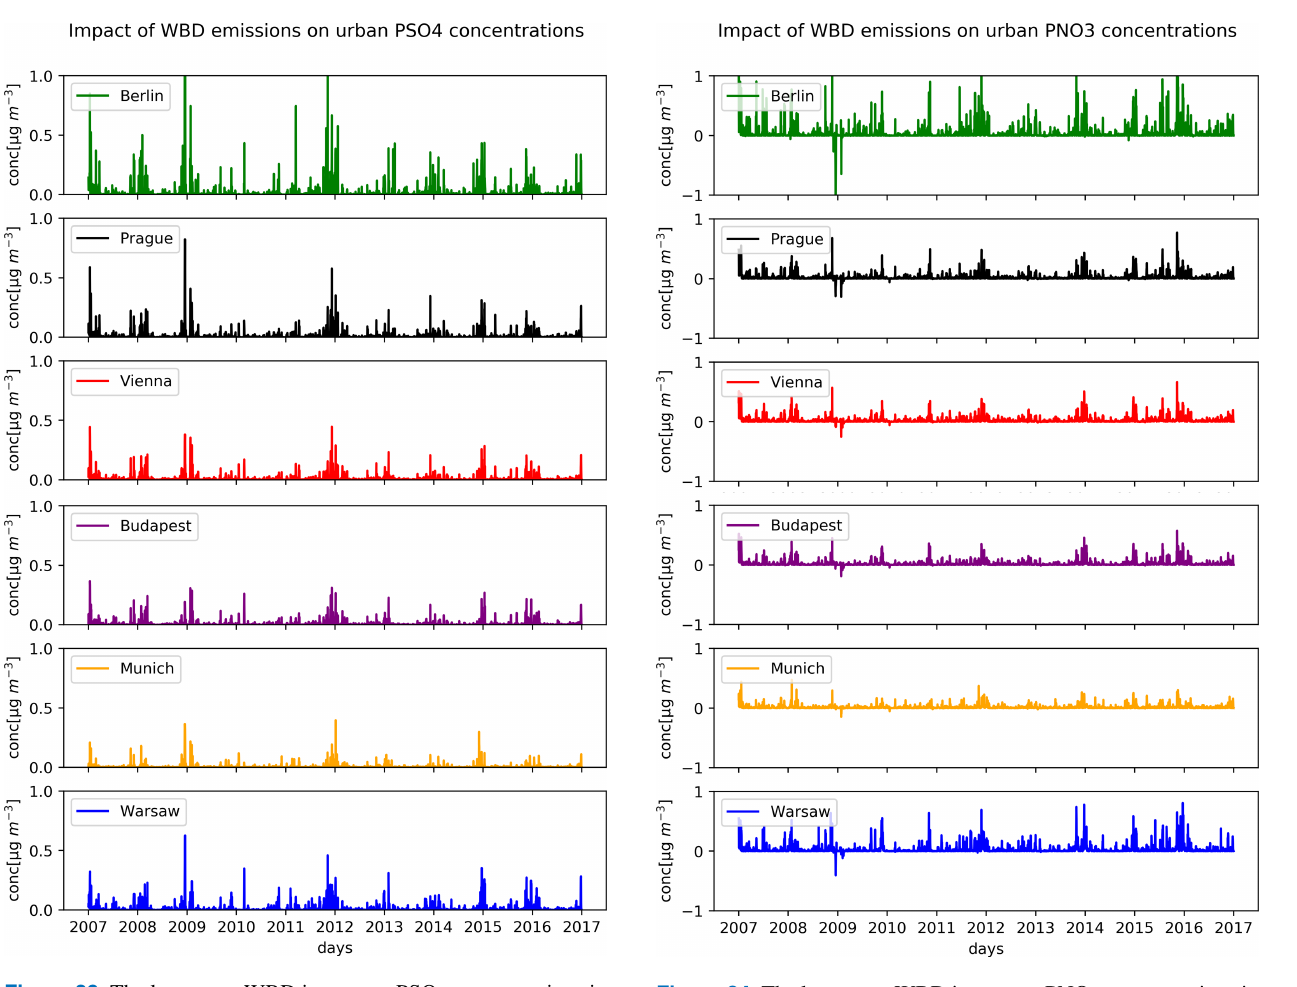
Figure 23. The long-term WBD impact on PSO 4 concentrations in ISORROPIA, averaged daily for 2007–2016. Units are micrograms per cubic metre.